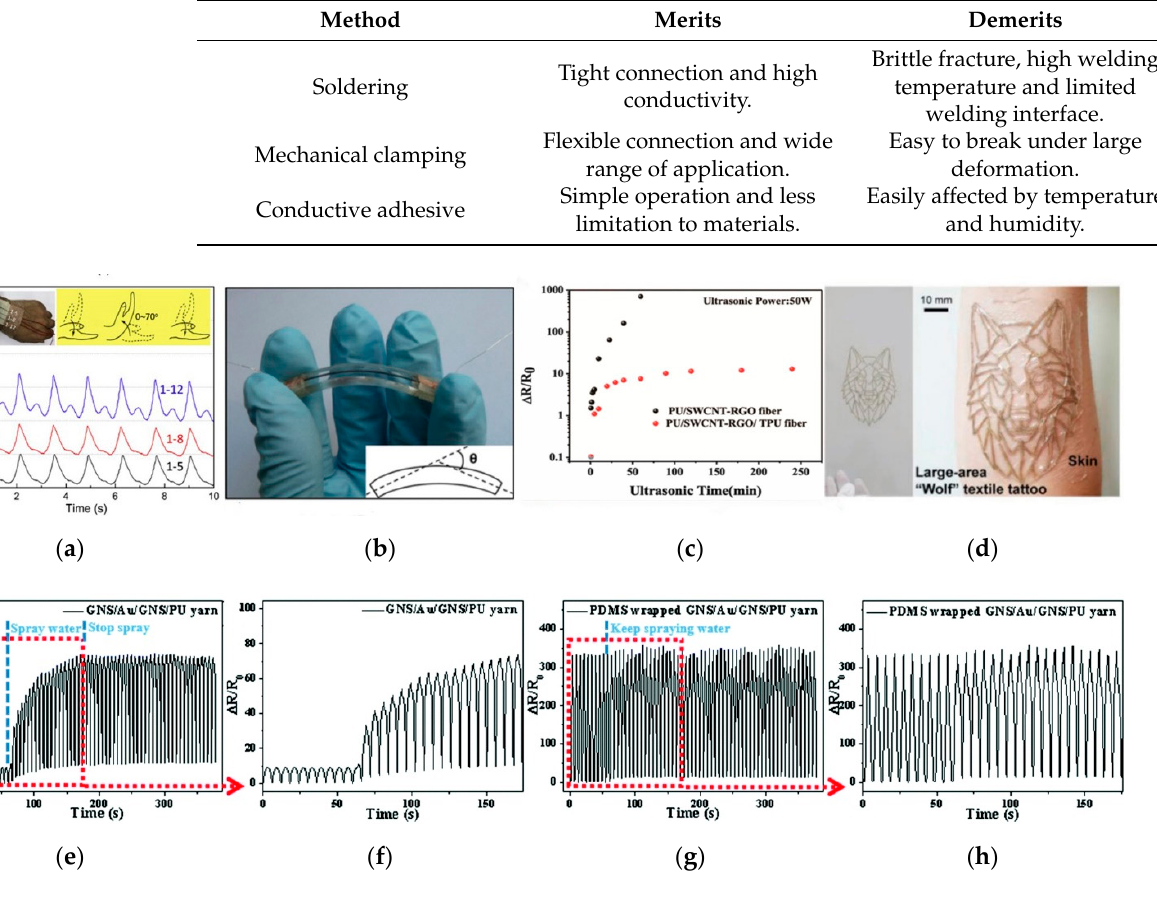
Figure 11. ( a ) MWCNT/TPU fiber sensors on an elastic bandage [72]. ( b ) The use of copper tape and silver paste to form the interconnections [96]. ( c ) Δ R/R 0 of the sensor with 50 wt% RGO as a function of ultrasonic time [106]. ( d ) Photograph showing a large textile tattoo of a wolf on skin [107]. ( e , f ) Resistance–time relationships of the GNS/Au/GNS/PU yarn strain sensor ( g , h ) Resistance–time relationships of the PDMS-wrapped GNS/Au/GNS/PU yarn strain sensor with an applied strain of 50% under water spray [42].